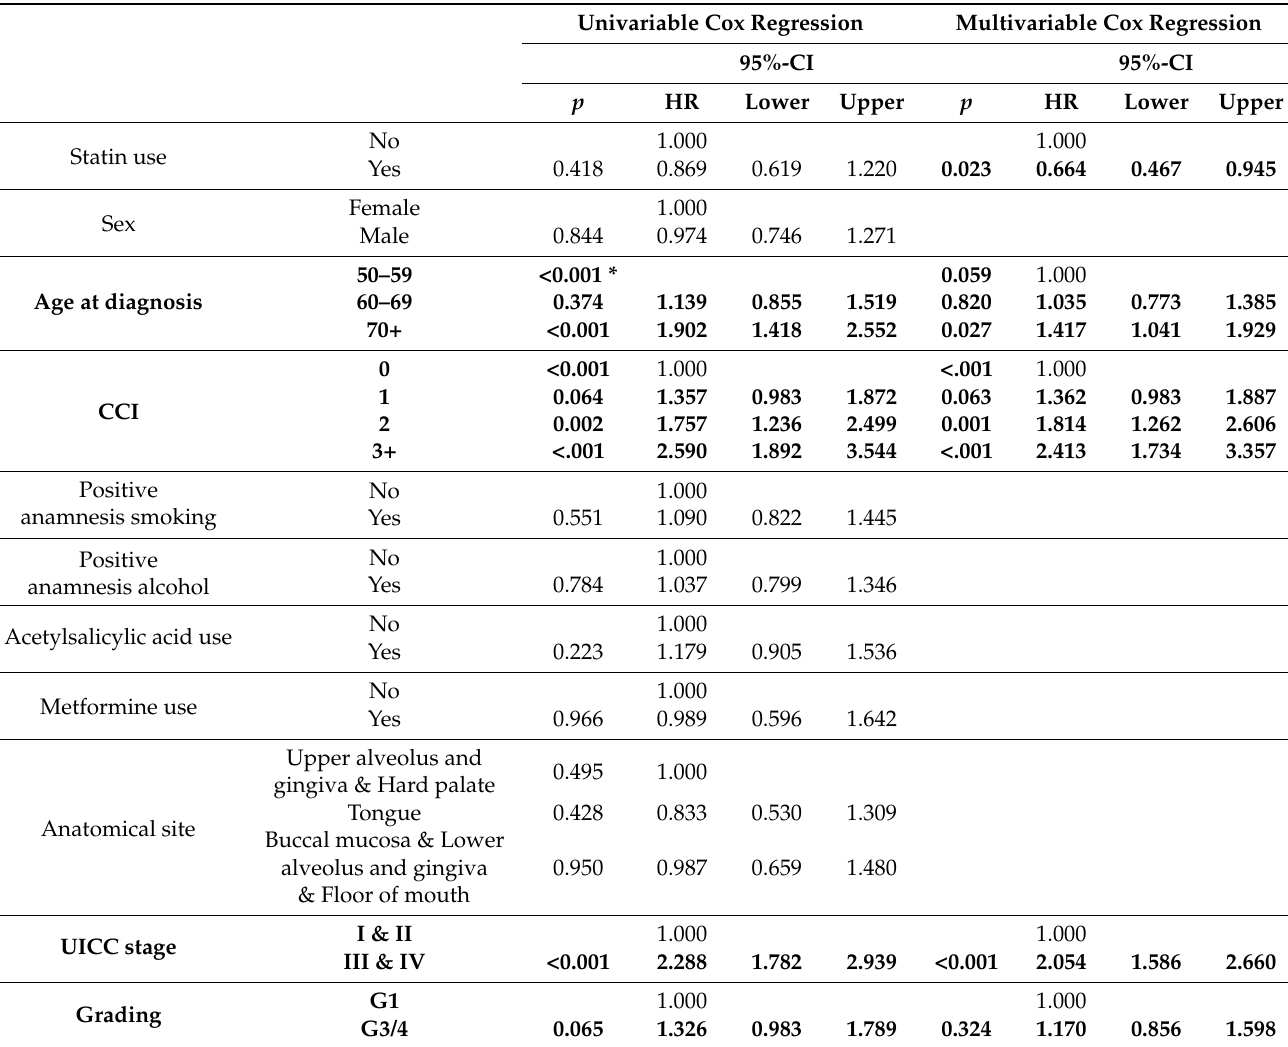
Table 2. Results from uni- and multivariable Cox regression analyses for overall survival in OSCC patients depending on statin use in complete cohort ( n = 602). UICC 7th